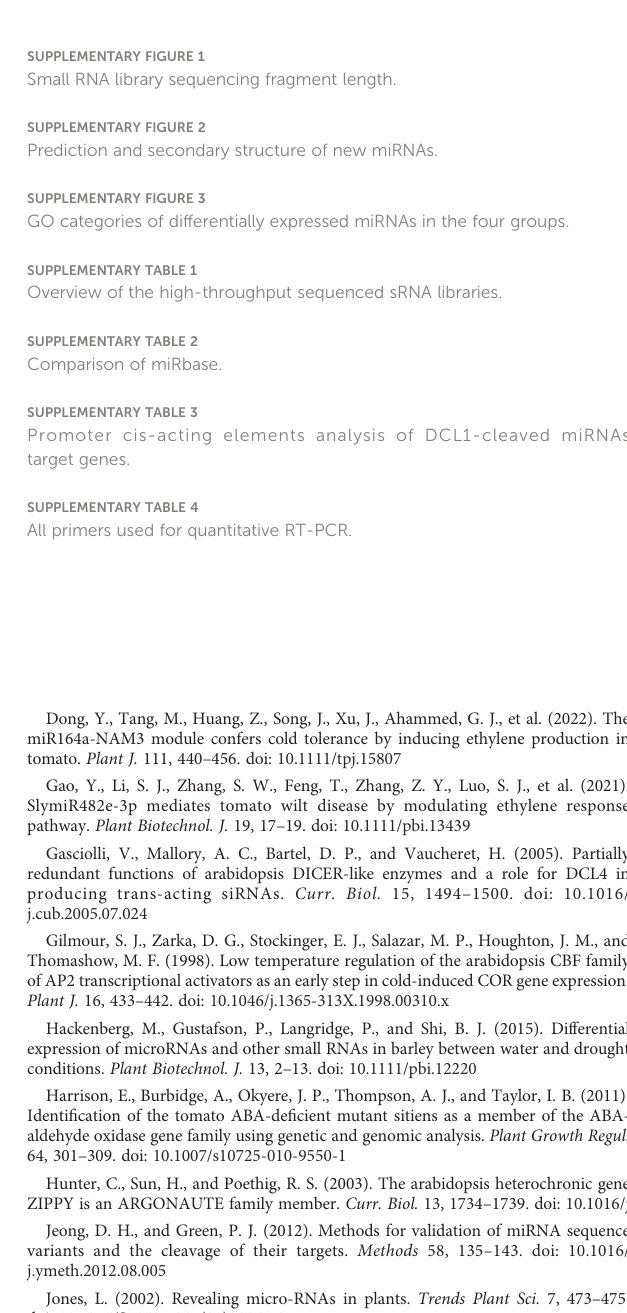
Prediction and secondary structure of new miRNAs.